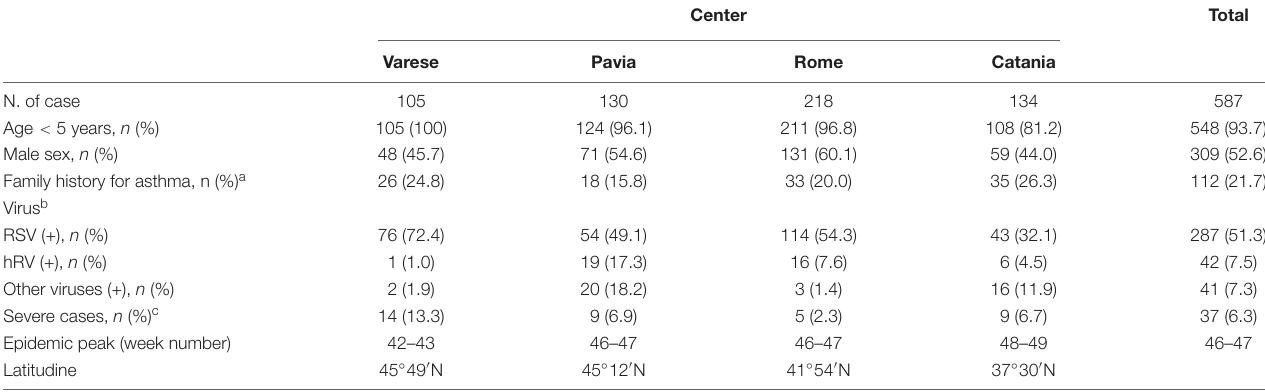
TABLE 1 | The main characteristics of the population studied in the participant